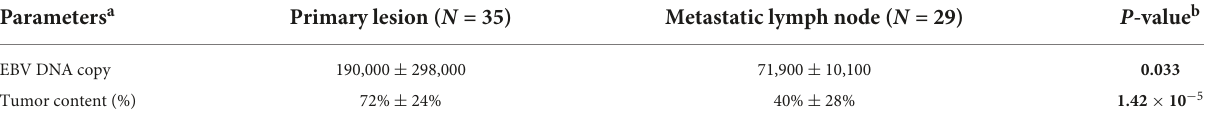
TABLE 4 Comparison of the Epstein–Barr virus (EBV) DNA between primary lesions and metastatic lymph nodes. Parameters a